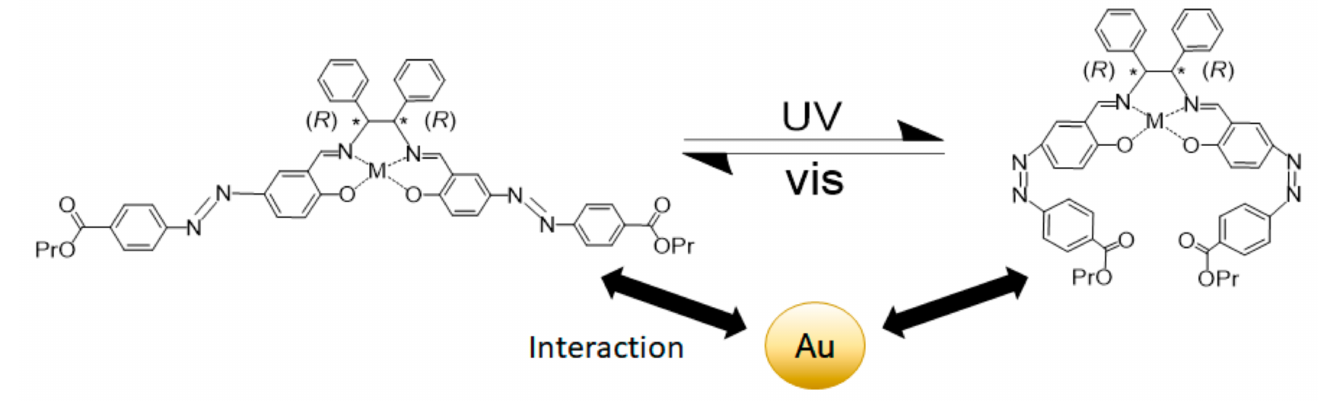
Figure 9. Photoisomerization of azobenzene moiety in chiral Schiff base complexes in the presence of gold nanoparticles (* denotes an asymmetric carbon atom). Reprinted with permission from Ref.